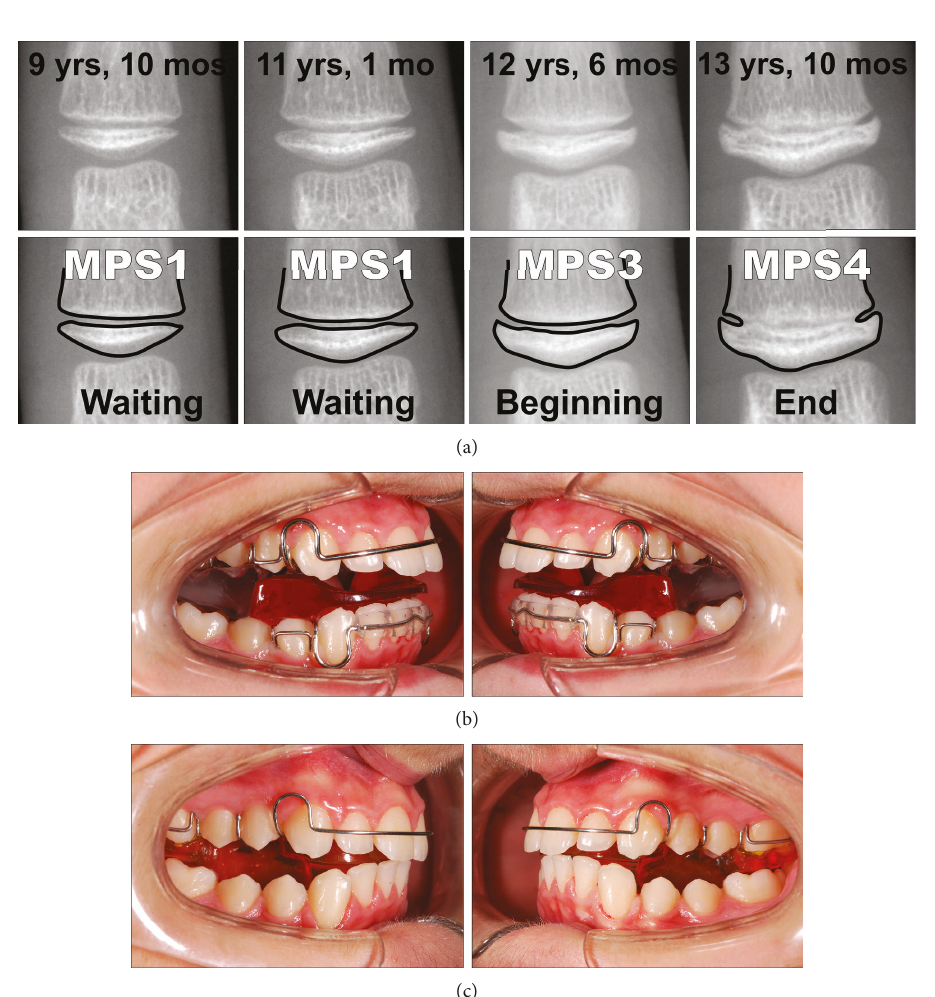
Figure 3: Case 1. (a) The series of the MPM recordings with corresponding ages and according to the timing of functional treatment (waiting before treatment, beginning of treatment, and end of treatment). (b) Intraoral views of the Twin-Block appliance. (c) Intraoral views of the removable Clark ’ s retention appliance.